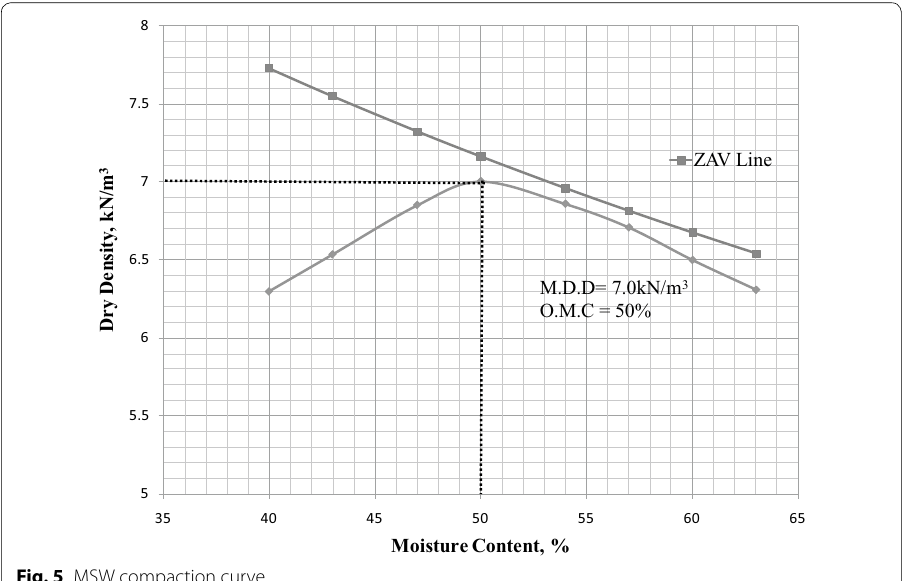
Fig. 5 MSW compaction